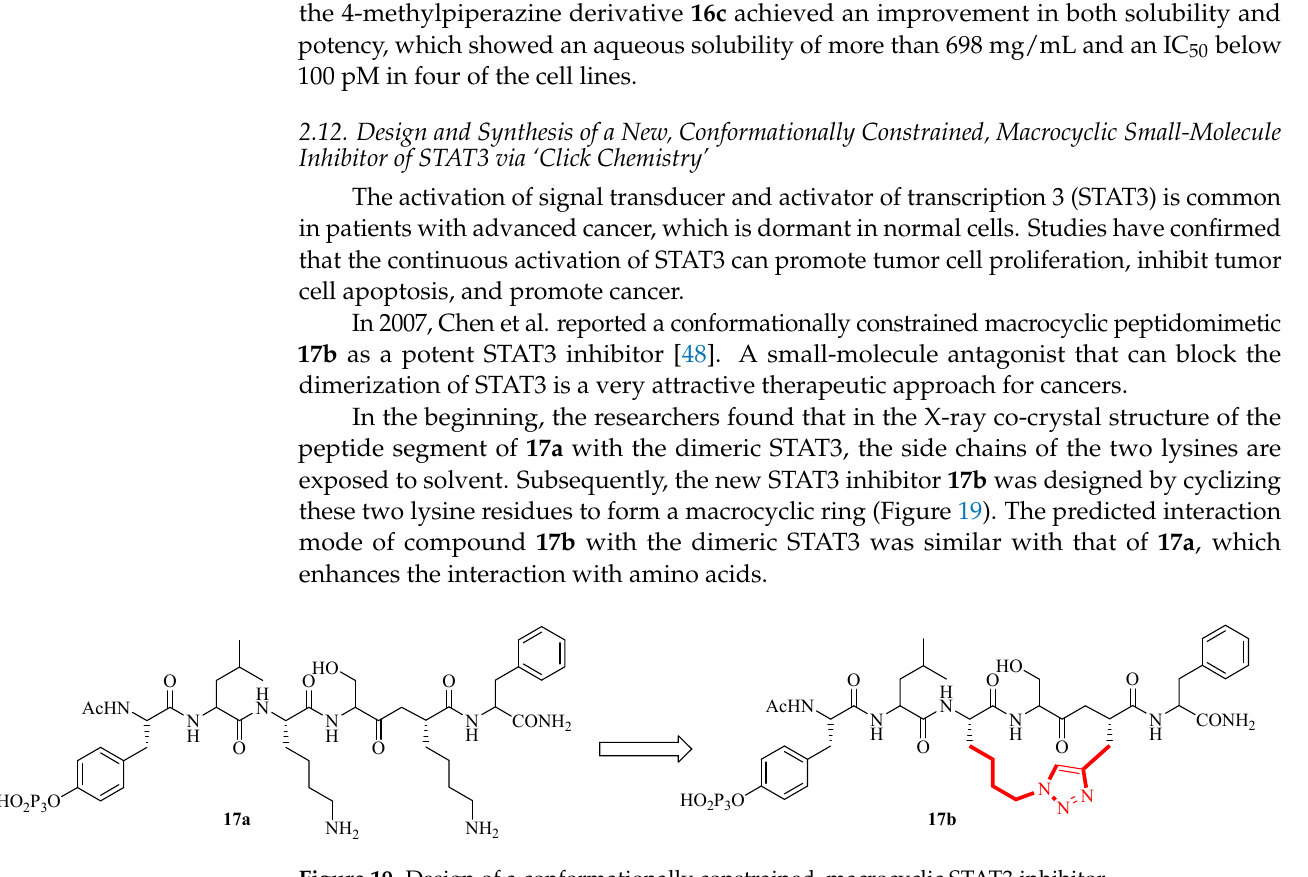
Figure 19. Design of a conformationally constrained, macrocyclic STAT3 inhibitor.